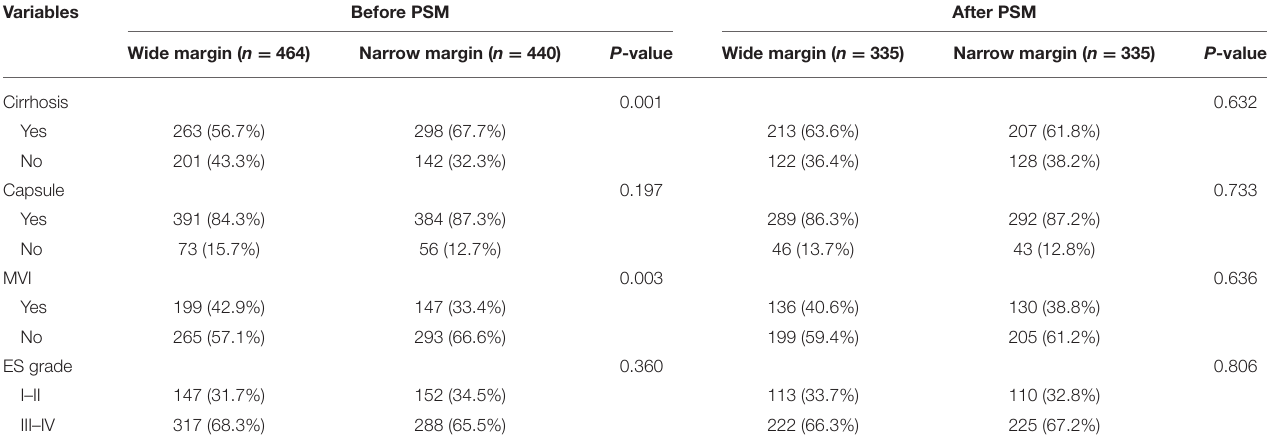
( Figure 1A : RFS, P < 0.0001, χ 2 = 37.9838; Figure 1B : OS, P = 0.0008, χ 2 = 18.2927). As such, patients who underwent a ≤ 2 mm surgical margin LR were defined as “narrow- margin” group ( n = 440); otherwise, “wide-margin” group ( n = 464). Supplementary Table 1 shows the χ 2 and P -values when other surgical margin distance values were used as the cutoff